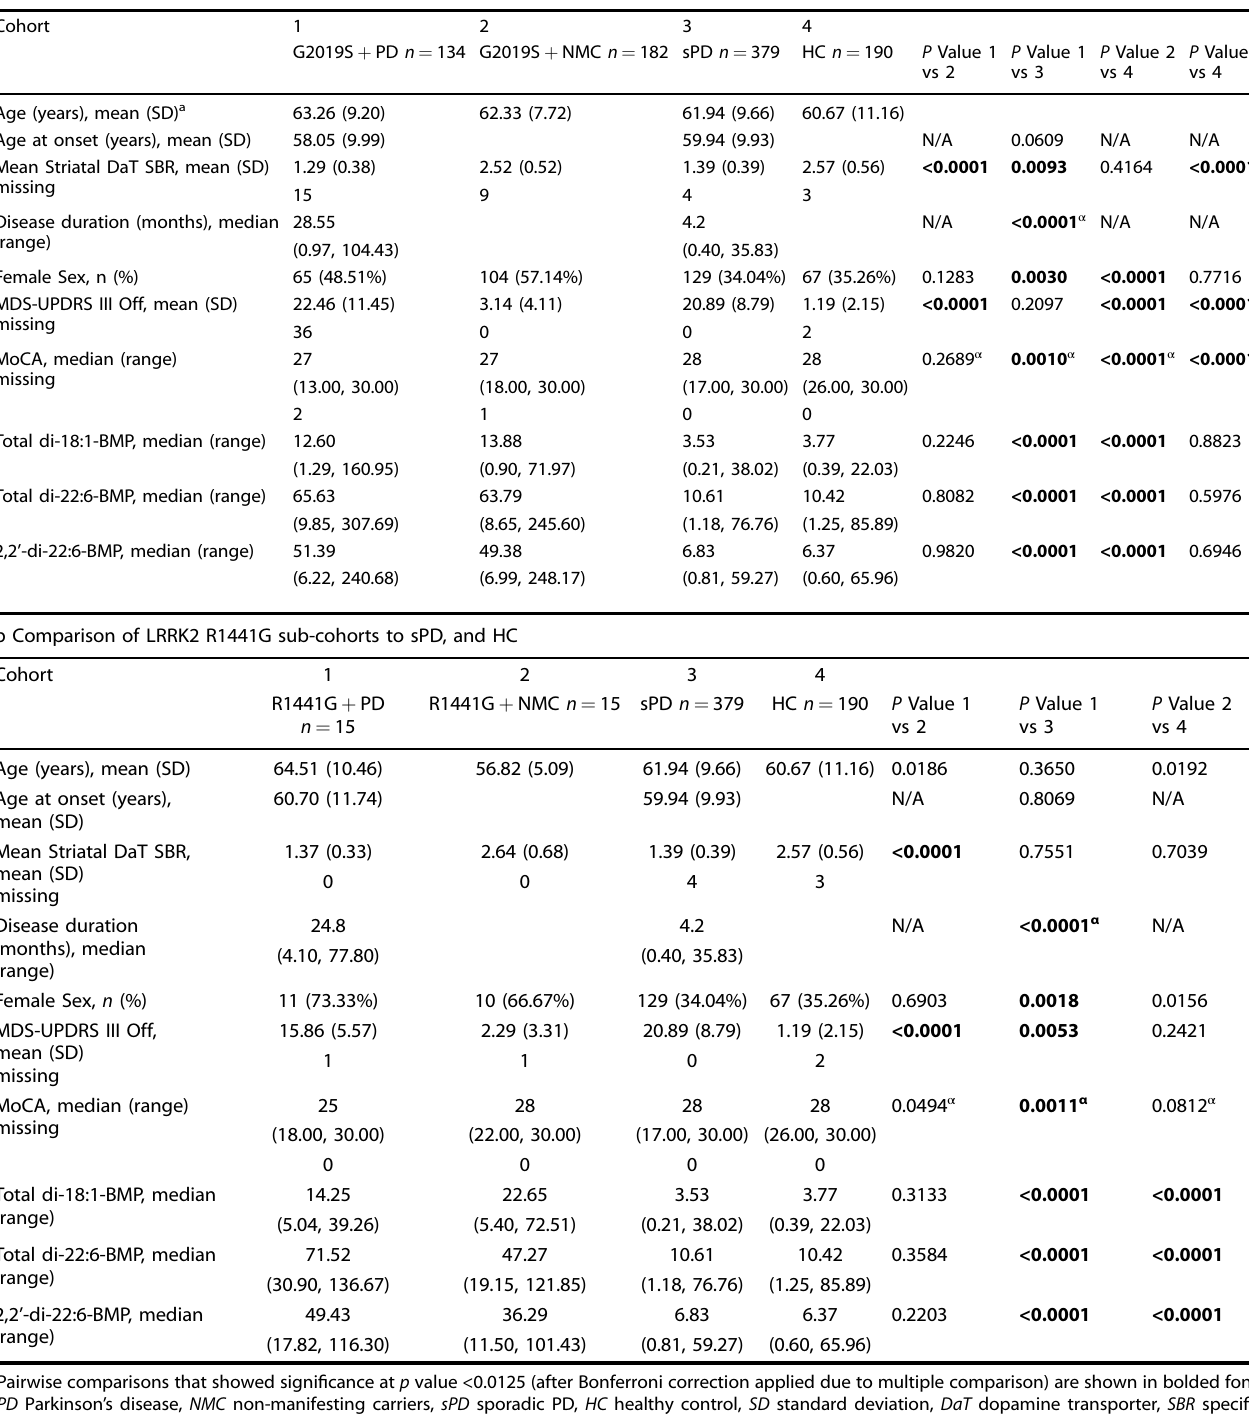
Table 1. Baseline demographics, clinical characteristics, mean striatal DaT SBR and BMP concentrations (adjusted for age and sex) in LRRK2, sPD and HC cohorts. a Comparison of LRRK2 G2019S sub-cohorts to sPD and HC